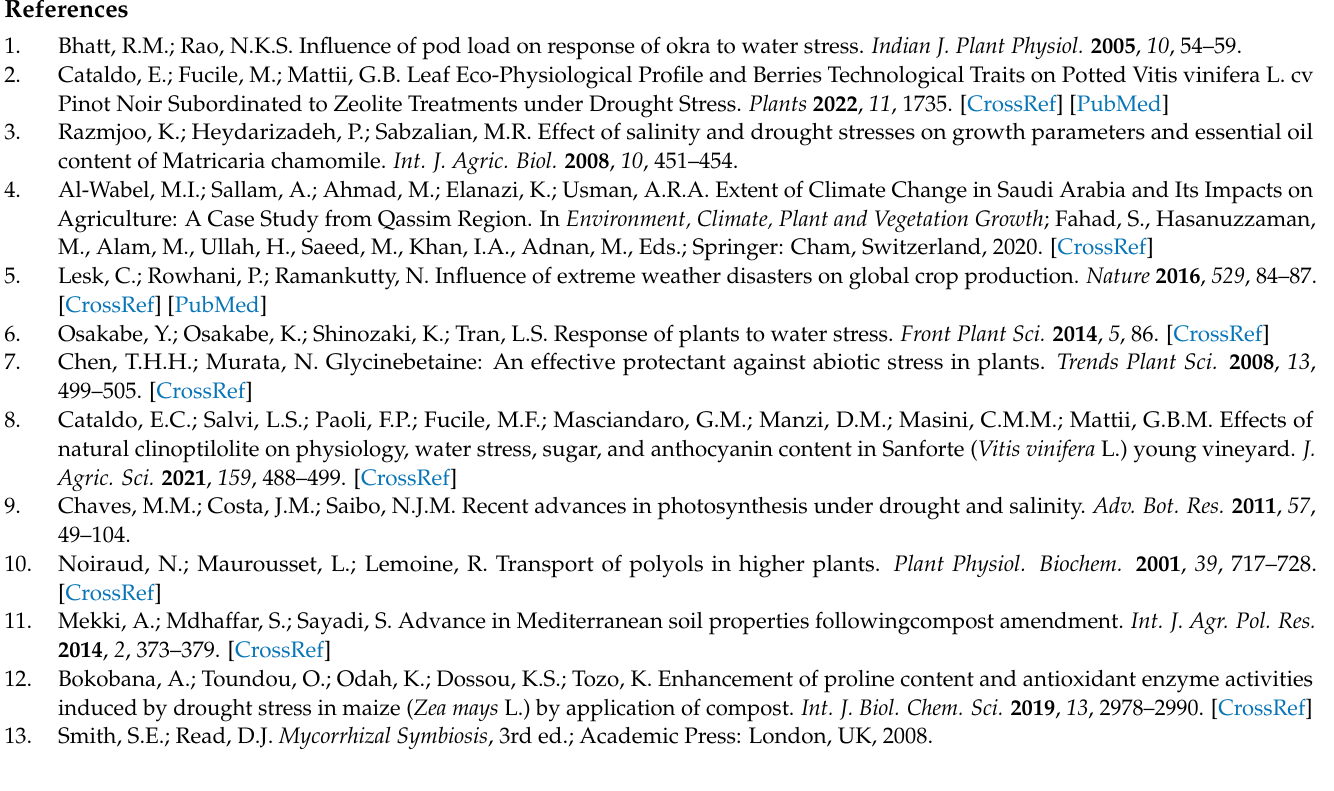
Table S2: Physicochemical properties of soil used in 2021 growing seasons. ± Standard deviation (4